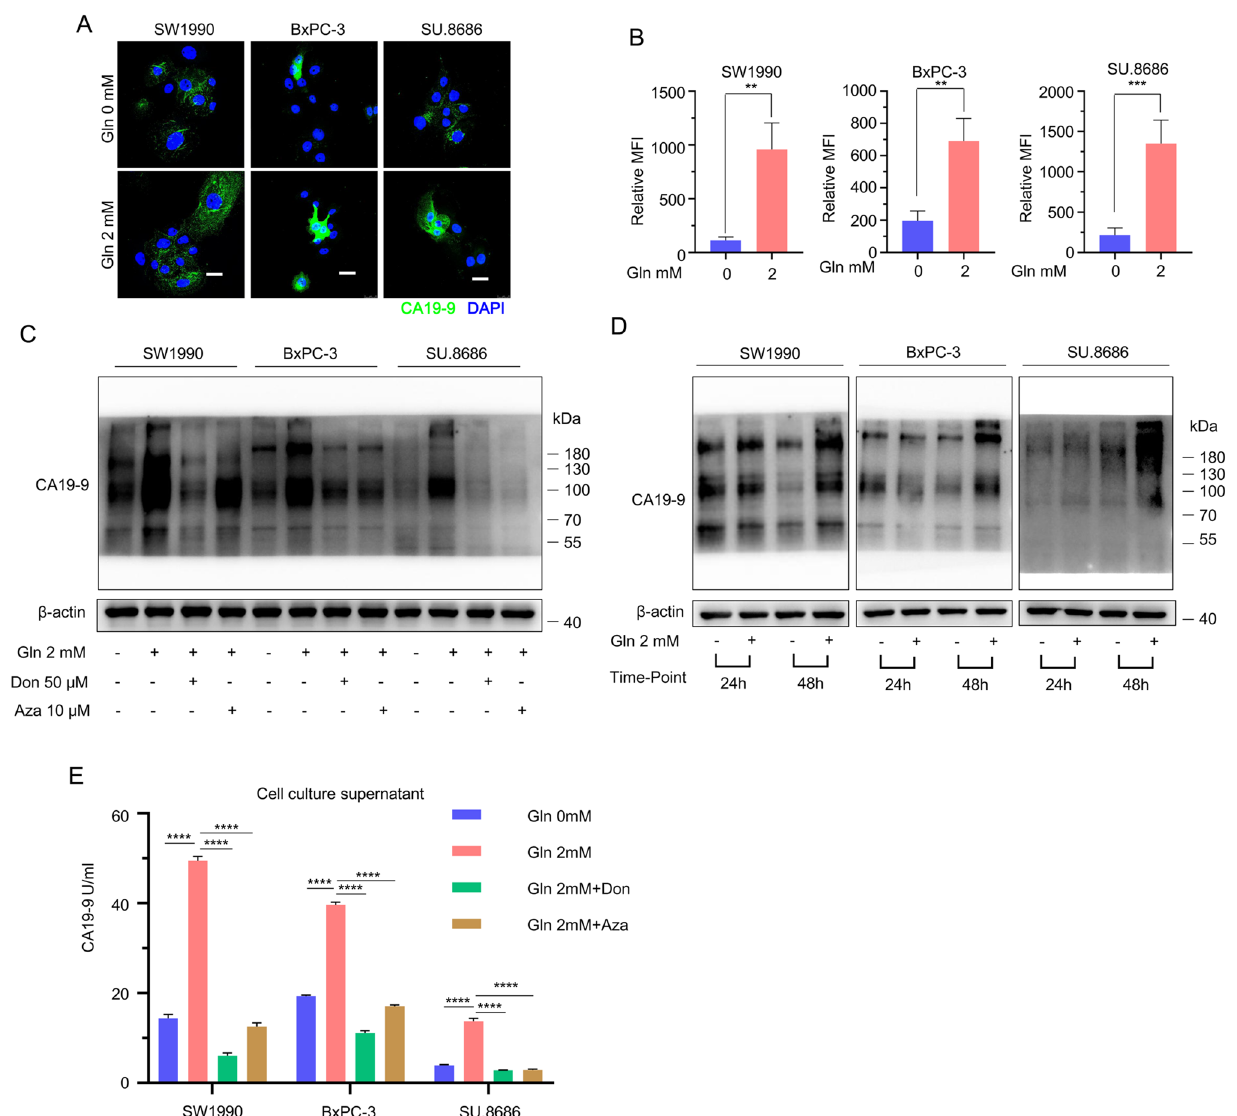
Fig. 6 Glutamine promotes CA19-9 biosynthesis in vitro. A , B The addition of 2 mM glutamine to glutamine-free medium increased the expression of CA19-9 in SW1990, BxPC-3, and SU.8686 cells, as observed by immunofluorescence confocal microscopy. Cells were cultured in different media for 72 h. Quantification is shown to the right. Data were randomly chosen in seven different fields. Scale bars, 25 μm. C The expression of CA19-9 in cells cultured for 72 h in glutamine-free medium, 2 mM glutamine medium, and 2 mM glutamine medium treated with 50 µM Don or 10 µM Aza was examined by Western blot. D The expression of CA19-9 in pancreatic cancer cells cultured in glu- tamine-free medium or 2 mM glutamine medium for 24 or 48 h was examined by western blot. E The concentration of CA19-9 in the super- natants of cells cultured for 72 h in glutamine-free medium, 2 mM glutamine medium, and 2 mM glutamine medium treated with 50 µM Don or 10 µM Aza was examined by electrochemiluminescence immunoassay. Three replicates per condition. All data are presented as the mean ± s.e.m. Three replicates per condition. Don diazooxonorleucine, Aza azaserine, UHPLC-MS ultrahigh performance liquid chromatog- raphy coupled with tandem Q-Exactive Orbitrap mass spectrometer. Data represent the mean ± s.e.m. *p < 0.05; **p < 0.01; ***p < 0.001; ****p < 0.0001. ns not